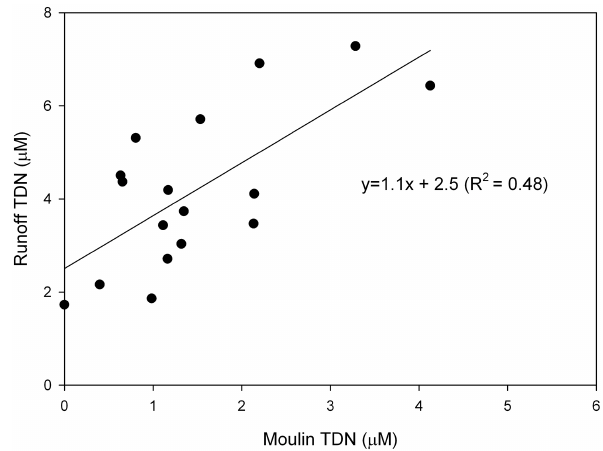
Figure 4. Association between the TDN concentrations measured simultaneously at the moulin and runoff monitoring sites (the cor- relation is significant at the 99% confidence level). Insets show the same data (excluding runoff samples) at low concentrations